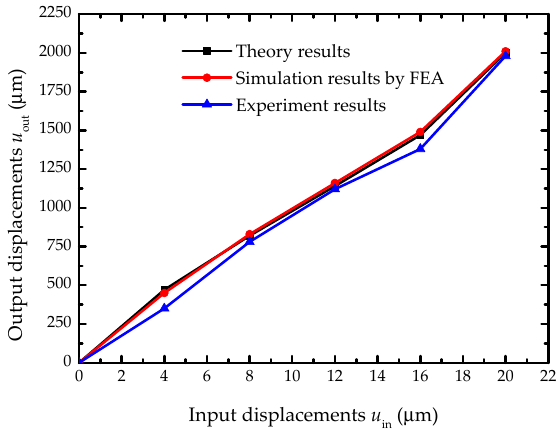
Figure 11. The comparison displacement curve between theory calculation, experimental deformation, and simulation results for the focusing mechanism based the two-stage flexural hinge lever-type mechanism.